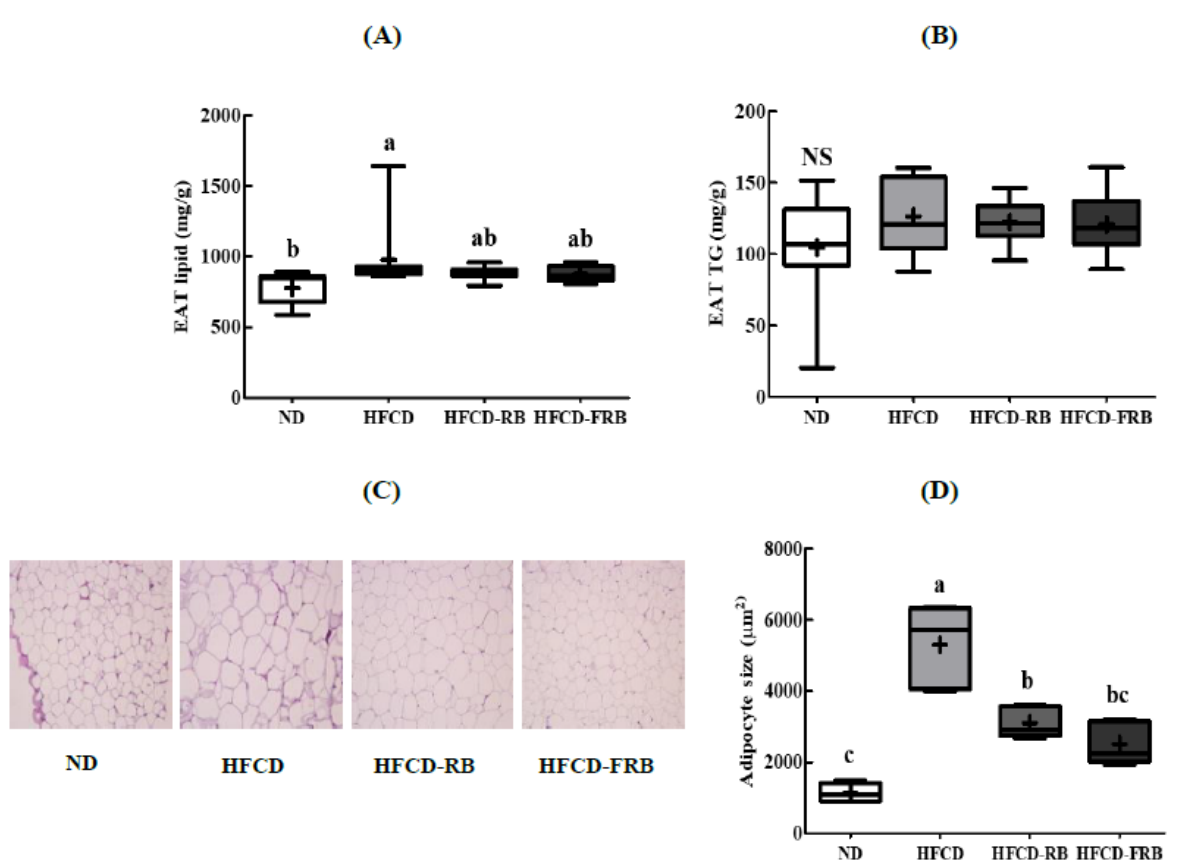
Figure 8. Epididymal adipose tissue lipid profiles and adipocyte size in mice fed experimental diets for 10 weeks. Diet groups: ND, normal diet group; HFCD, high-fat and -cholesterol diet group; HFD-RB, HFCD + non-fermented rice bran powder group; HFCD-FCA, HFCD + fermented rice bran powder group. ( A ) Lipid, and ( B ) triglyceride (TG) were measured from the epidydimal adipose tissue (EAT); ( C , D ) EAT was stained with hematoxylin and eosin (HE). Magnification, 100×. Values are displayed as a Box-and-Whisker plot with means (expressed as ‘+’), n = 10. a–c: bars with different letters are significantly different at p < 0.05 by Tukey’s post hoc test.